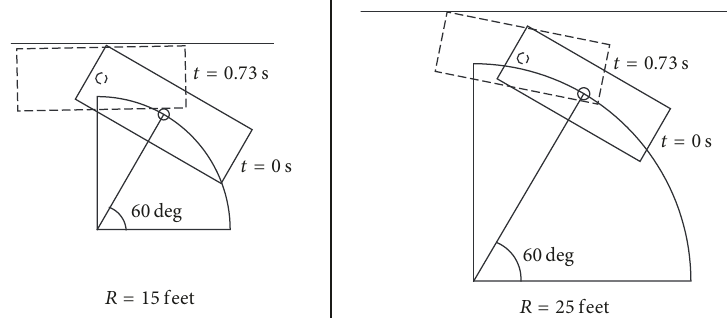
Figure 5: Two time-lapse sequences; each panel depicts a single vehicle’s wheels-locked braking maneuver. Parameters: 𝑟 = 15 󸀠 (L) and 𝑟 = 25 󸀠 (R), 𝛽 = 60 ∘ , and V = 15.2 mph. Solid-outline vehicle and dashed-outline vehicle depict location at time of 𝑡 = 0 and 𝑡 = 0.73 seconds,